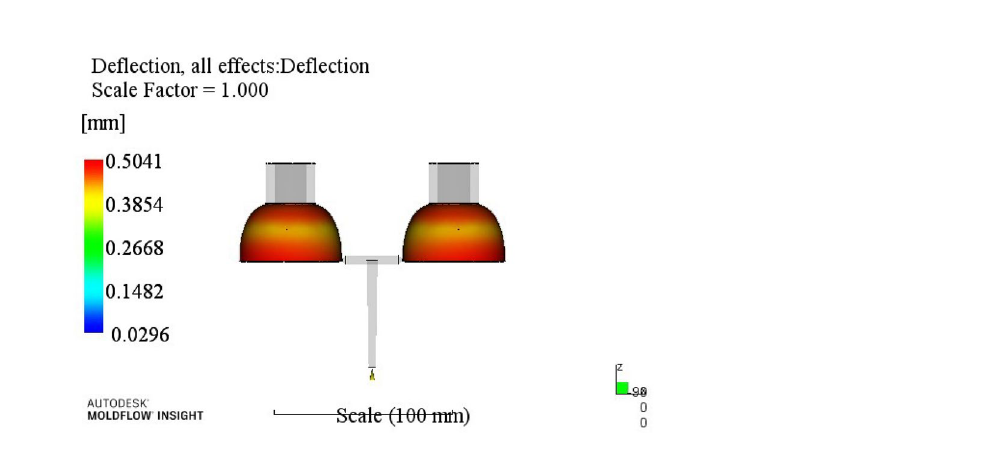
Figure 8. The simulation results of the warping